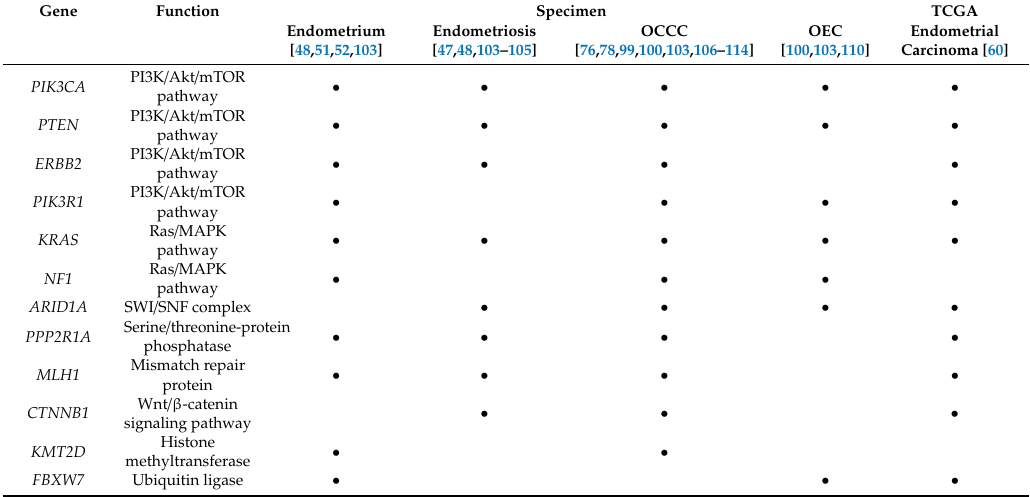
Table 1. Previous report of gene alteration in endometrium, endometriosis, endometriosis-associated ovarian cancer, and endometrial